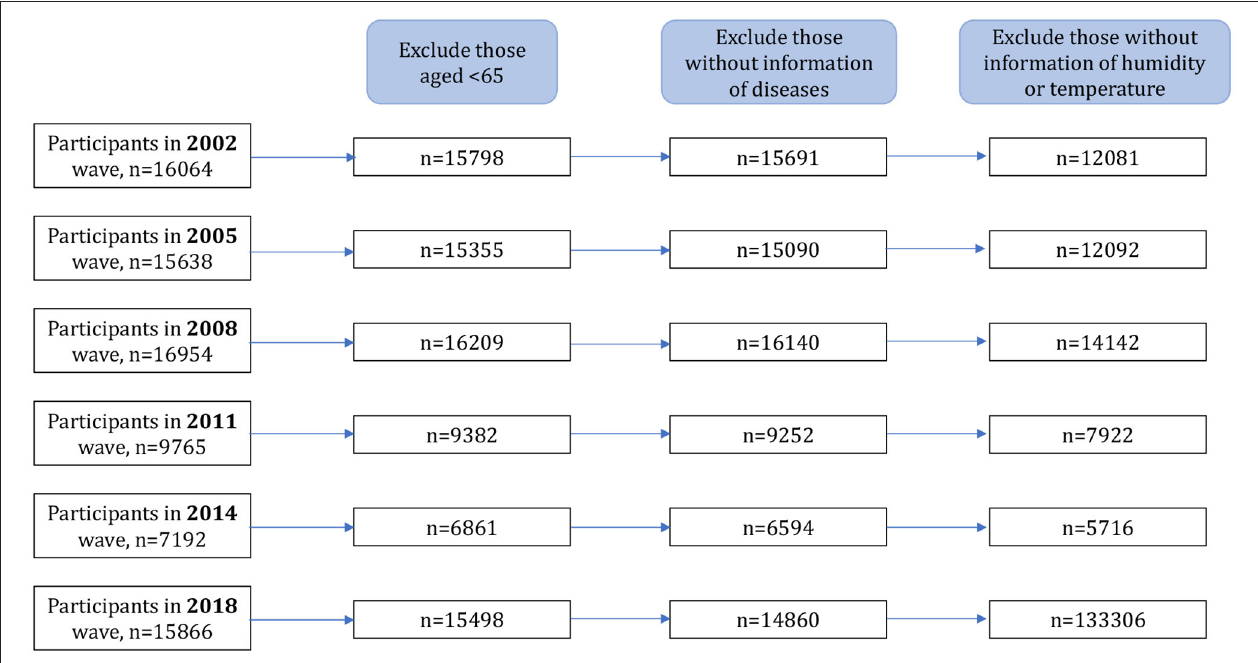
FIGURE 1 | Flow chart of the